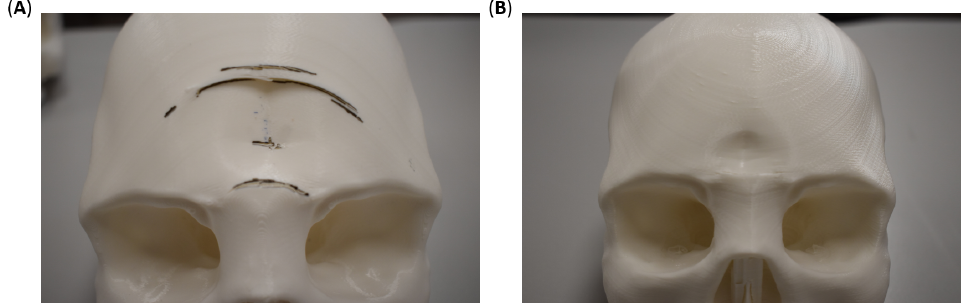
Figure 9. Fracture patterns (shown in black lines) in 3D-printed ( A ) coronal-cut and ( B ) whole skulls after lateral compressive testing.